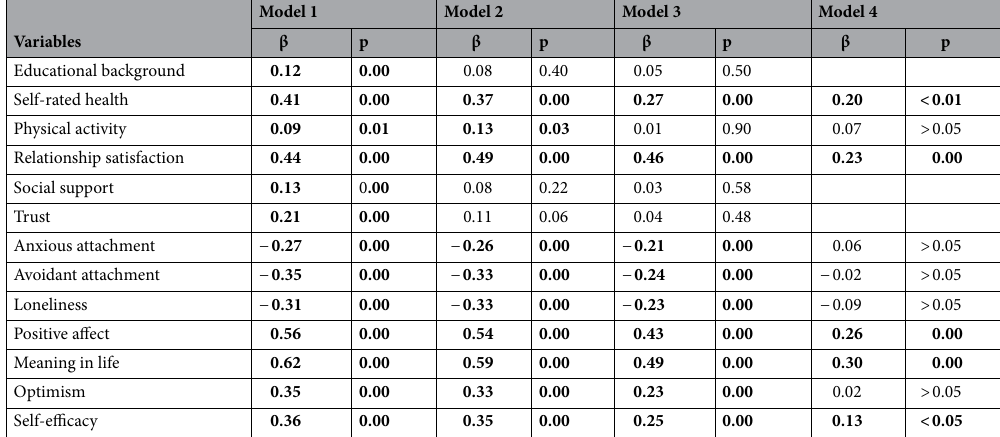
Table 5. Regression analyses for type 2 resilience. Significant effects (p < 0.05) in bold type. N varies between 415 and 888. See Method section and Table 1 for more information. Model 1: Linear model, standardized, with control for sex and age, for each variable separately. Model 2: Linear mixed model, standardized, with control for sex, age and genetic confounding, for each variable separately. Model 3: Linear mixed model, standardized, with control for sex, age, genetic confounding and the other resilience measure, for each variable separately. Model 4: Multivariate linear mixed model, standardized, with control for sex, age and genetic confounding, with all significant variables from Model 2